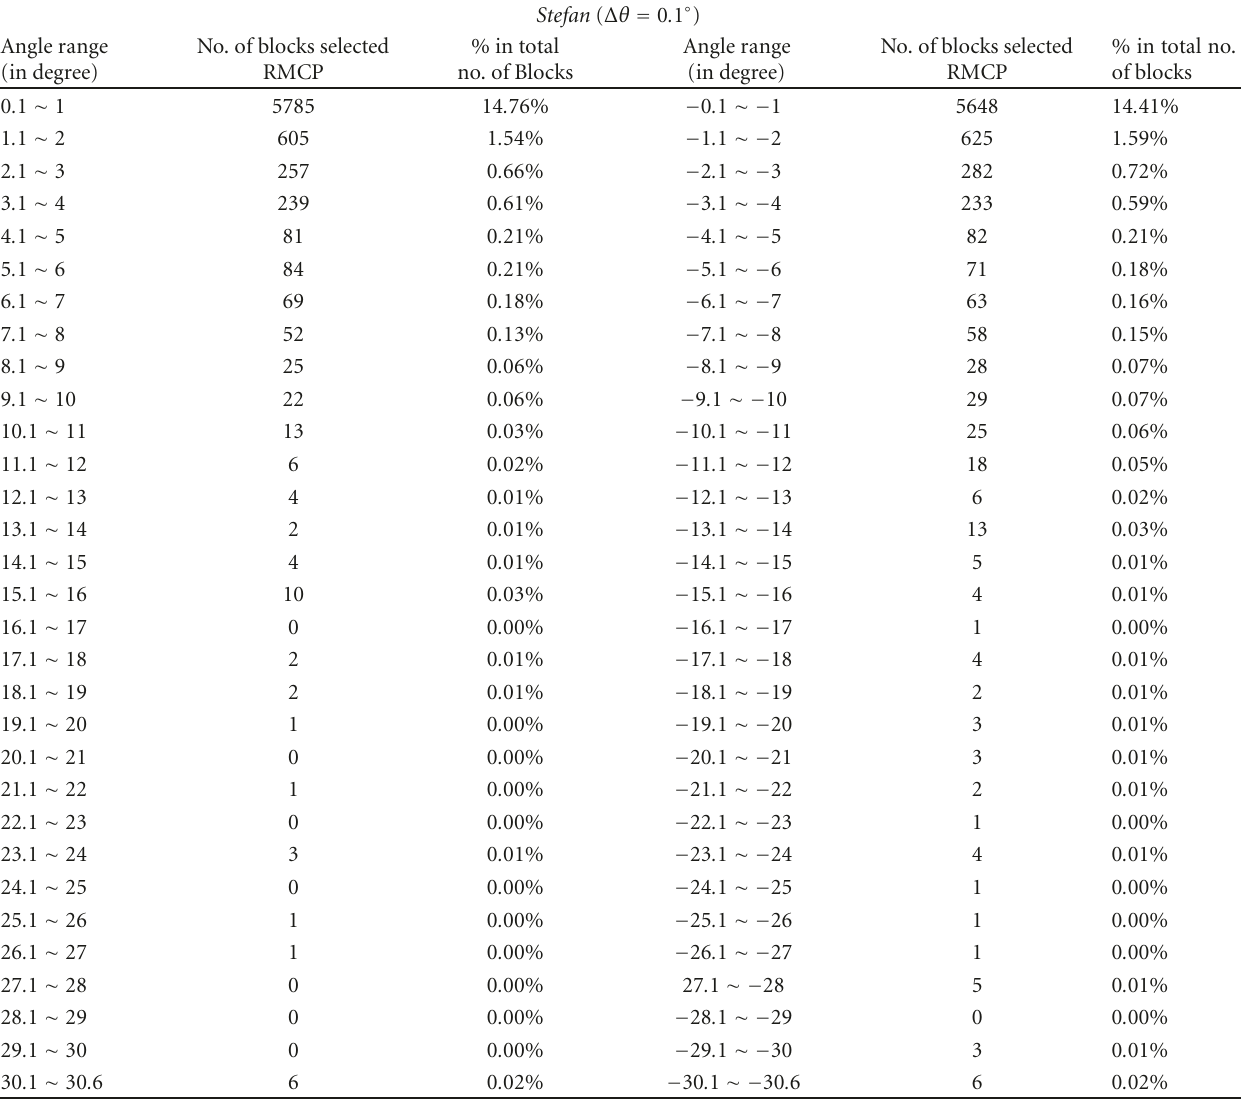
Table 2: Rotation angle distribution in sequence Stefan